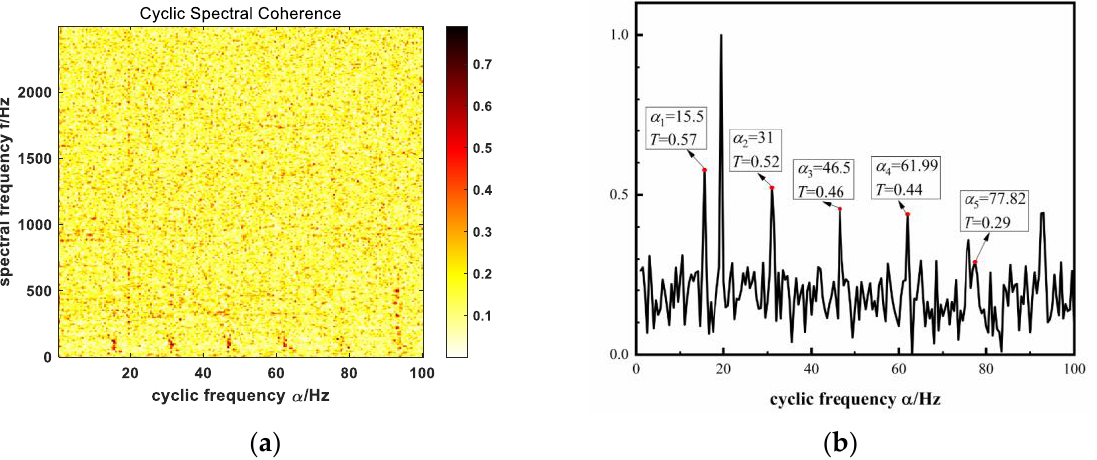
Figure 9. ( a ) The cyclic spectrum coherence function graph of the Robinson R44 helicopter at 4.114 km; ( b ) the cyclic frequency detection results of the Robinson R44 helicopter at 4.114 km.